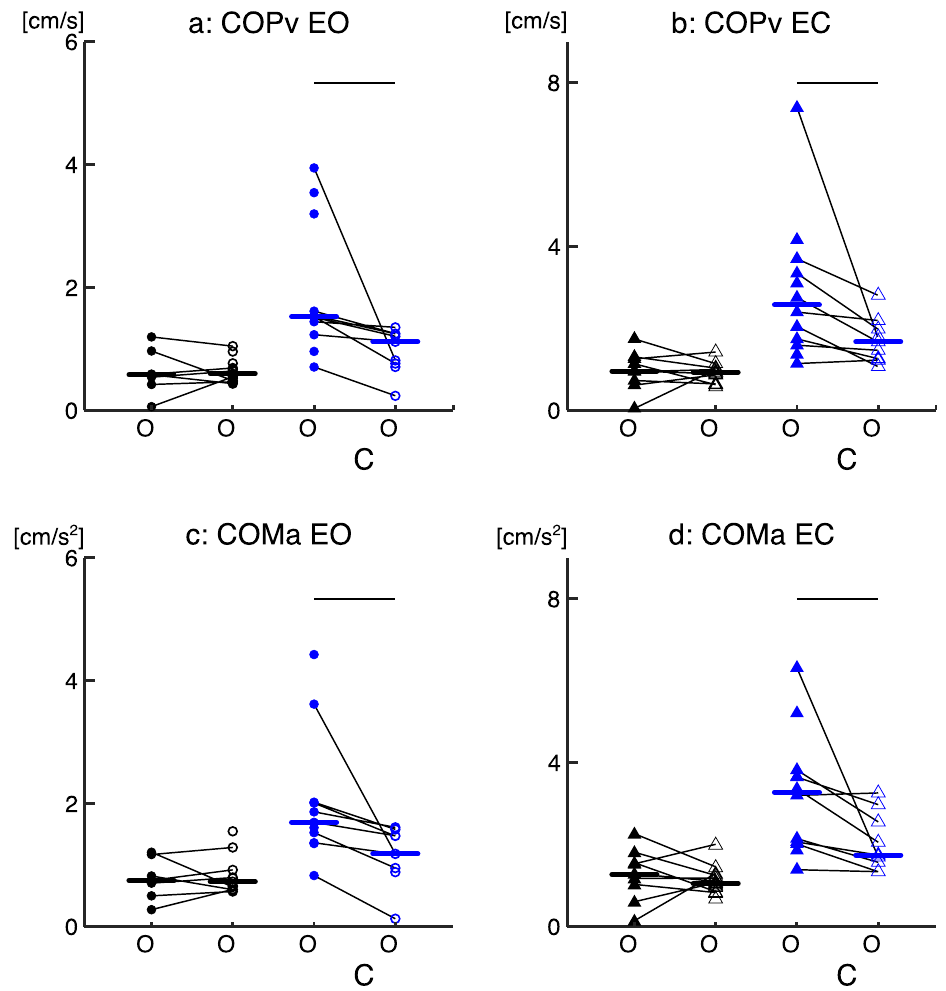
Figure 5. Comparison of the postural sway (standard deviation of the COPv and COMa) during TA on and TA off between the AB- and iSCI-group. ( a ) Distribution of the fluctuation of the COPv in the EO. ( b ) Distribution of the fluctuation of the COPv in the EC. ( c ) Distribution of the fluctuation of the COMa in the EO. ( d ) Distribution of the COMa in the EC condition. Whole body COPv and COMa group data presented for the AB-group (black) and iSCI-group (blue) in both EO (circles) and EC (triangles) conditions for periods of co-contraction (On—filled shape) and no-co-contraction (Off—open shape). Horizontal lines represent the group median. Each point represents an individual participant’s data, thin black lines between data points connect the same participant and thin horizontal lines above the plots represent significant differences (p < 0.05). Thick horizontal lines within data points represent group